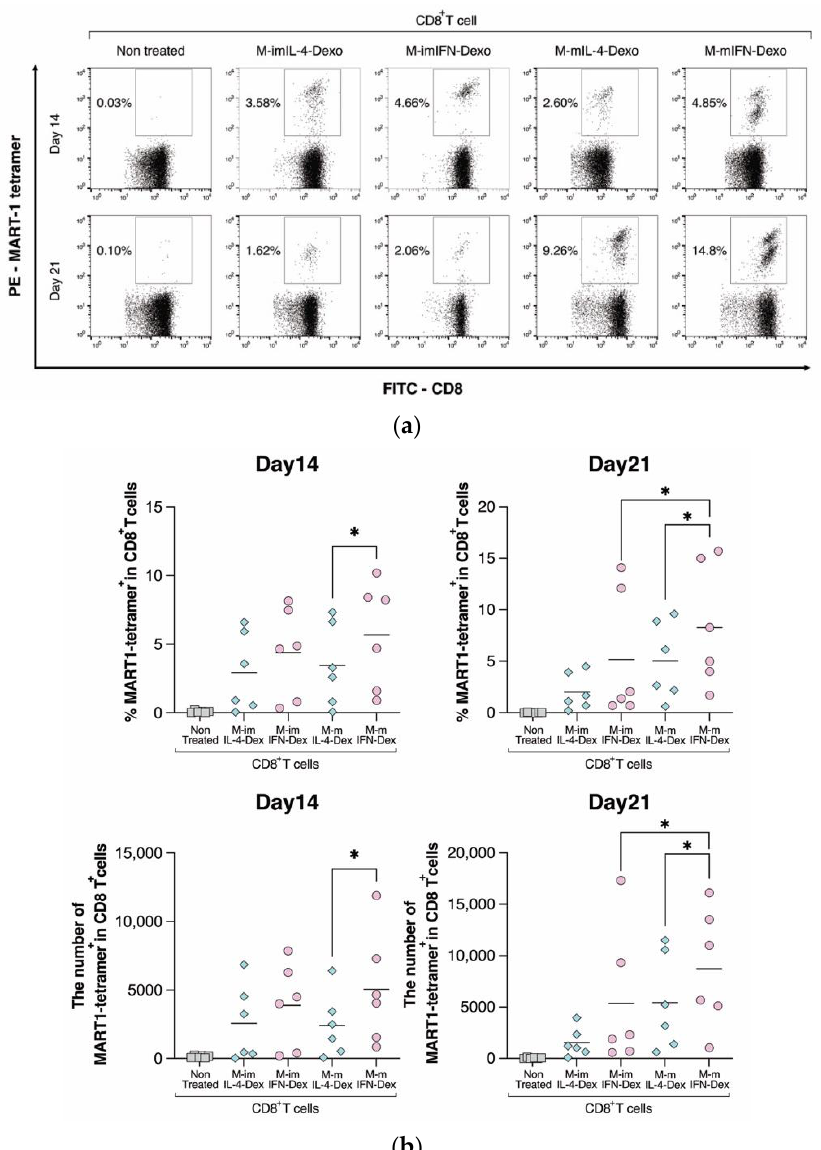
Figure 6. Comparison of MART-1-specific CD8 + T cell induction in immature and mature MUTZ- 3-derived IL-4- and IFN-DC dexosomes. MUTZ-3-derived IL-4- and IFN-DC dexosomes were cocultured with autologous T cells at a ratio of 2000:1 (dexosomes:T cells). MART-1-specific CD8 + T cells were detected via CD3, CD8, and MART-1 + tetramers using flow cytometry 14 and 21 days after the start of the co-culture. ( a ) These dot plots show a representative example. The percentages in the panels indicate the MART-1 tetramer + ratio in CD8 + T cells. ( b ) The graph shows the number of MART-1 tetramer + /CD8 + T cells in the culture period. The bold horizontal bars indicate the mean of each parameter. * p < 0.05 indicates a statistically significant difference ( n = 6). The rhombus in the Scatter plot is MUTZ-3 derived IL-4-DCs. Circle is MUTZ-3 derived IFN-DCs. Square is MUTZ-3